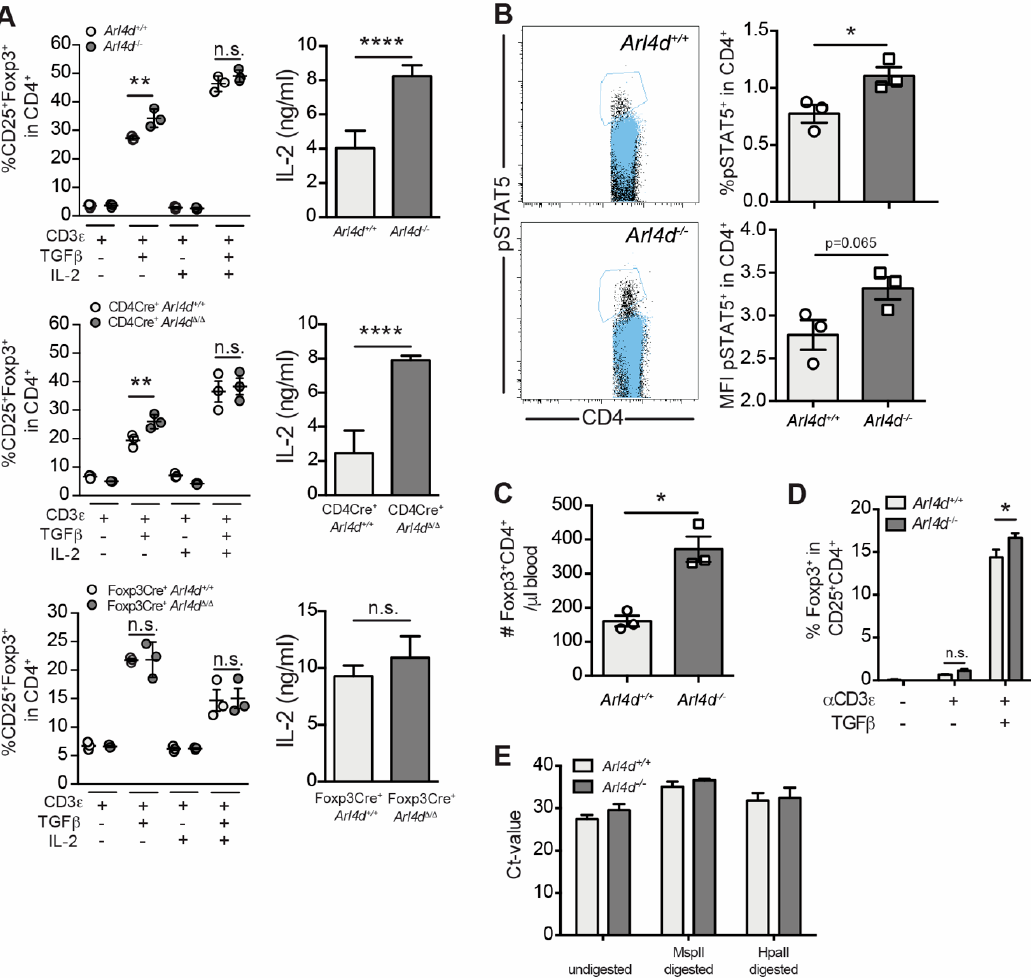
Figure 4. Differential capacity for IL-2 production associated with enhanced T reg differentiation in- duced by Arl4d expression in CD4 T cells. Splenic CD4 + T cells from Arl4d − / − , CD4-Cre + xArl4d Δ / Δ , and Foxp3-Cre + xArl4d Δ / Δ mice and their respective wild-type controls were stimulated with plate-bound α CD3 ε (1 μ g/mL) in the presence or absence of mTGF β (8 ng/mL) or 100 IU/mL rhIL-2 for 48 h, after which cells and supernatants were harvested and analyzed by flow cytometry and ELISA. ( A ) Per- centages of CD25 + Foxp3 + cells within viable CD4 + T cells and the respective mIL-2 concentration (after α CD3 ε stimulation) in the supernatant after 48 h of culture. ( B ) Ex vivo pSTAT5 staining of splenic CD4 + T cells from Arl4d +/+ or Arl4d − / − mice. Dot plots show pSTAT5 staining (black dots) overlayed with isotype staining (blue dots). Bar graphs show the percentages and MFI of pSTAT5 in CD4 + and pSTAT5 + cells, respectively. ( C ) Absolute numbers (#) of Foxp3 + CD4 + cells per μ L of blood in Arl4d +/+ and Arl4d − / − mice. ( D ) CD25 high depleted splenic CD4 + T cells were stimulated with plate-bound α CD3 ε (1 μ g/mL) in the presence or absence of mTGF β (8 ng/mL) for 48 h, after which cells were stained for CD4, CD25, and Foxp3 ( n = 3). ( E ) Undigested or digested genomic DNA from sorted splenic Arl4d +/+ and Arl4d − / − CD4 + CD25 high T cells was subjected to qPCR analysis of the Foxp3 promoter. Ct values of HpaI-digested samples that lie between the Ct values of undigested and MspII-digested samples indicate partial methylation ( n = 2). Representative data of 3–4 ( A ) and 2 ( B , C ) experiments with n ≥ 3 ( B , C ). Statistical significance was determined by Student’s t